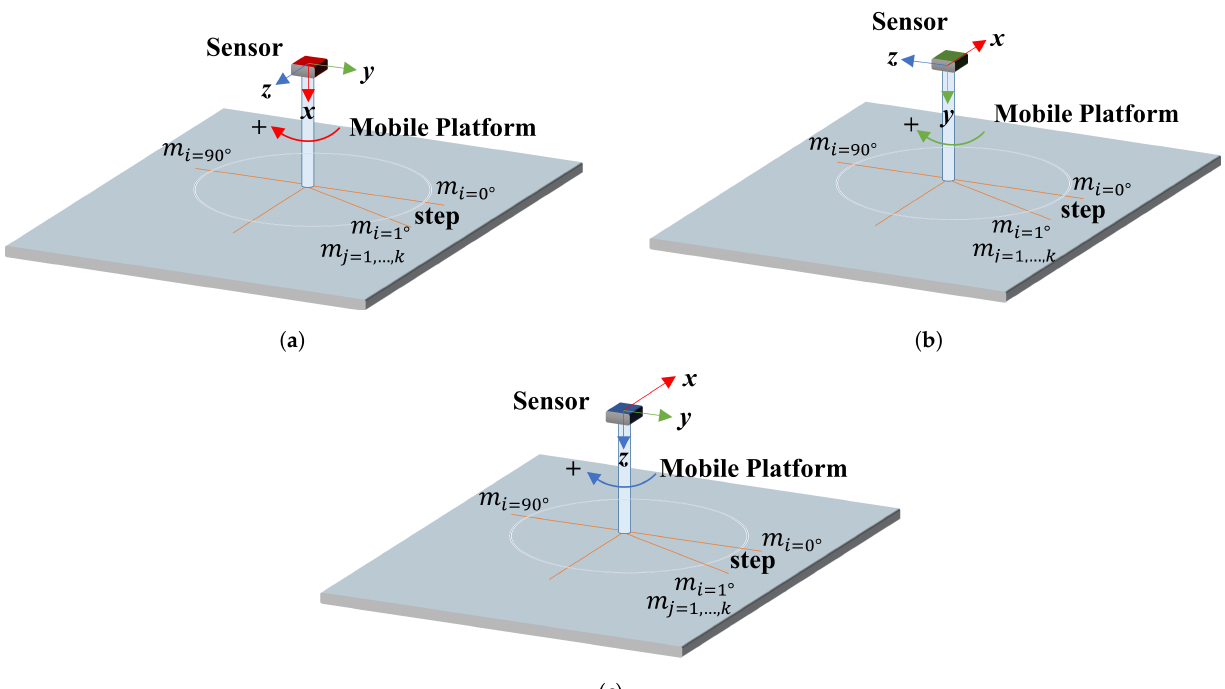
Figure 8. Schematic for evaluating the accuracy, repeatability, and total error, in ( a ) x – roll , ( b ) y – pitch , and ( c ) z – yaw axes of the orientation sensors.